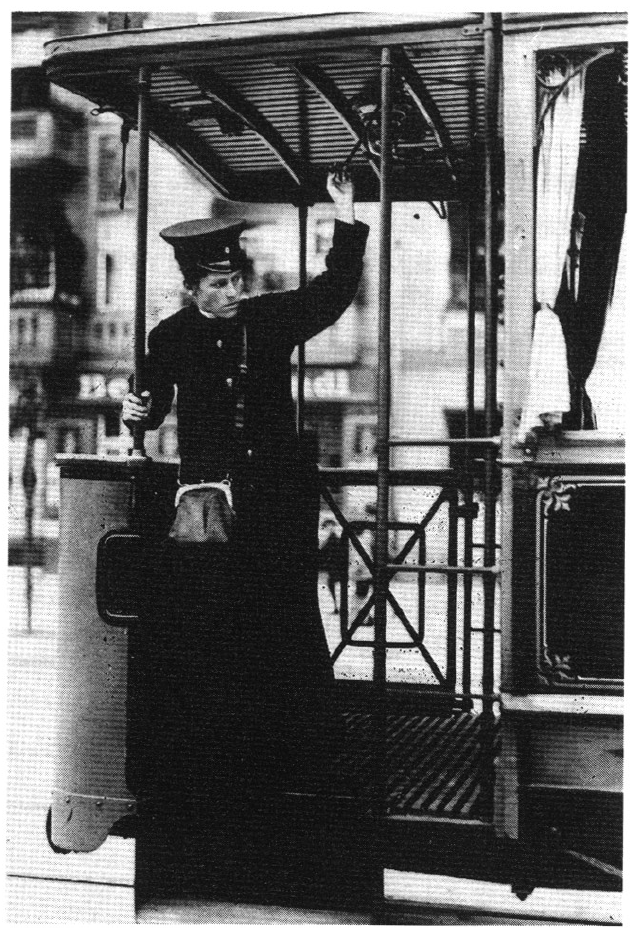
A. Grohs, Illustrations-Verlag, Schaffnerinnen der großen Berliner Straßenbahn als Ersatz für ihre in den Krieg gezogenen Männer (Female Conductors of the Great Berlin Streetcars as Replacements for their Husbands who have Gone to War). c. 1915. Bibliothek für Zeitgeschichte in der Württembergischen Landesbibliothek Stuttgart (File Nr. 80). 18 x 13